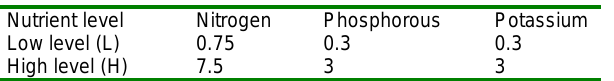
Table 1. Levels of available soil nutrient used for the 8 treatments (unit: